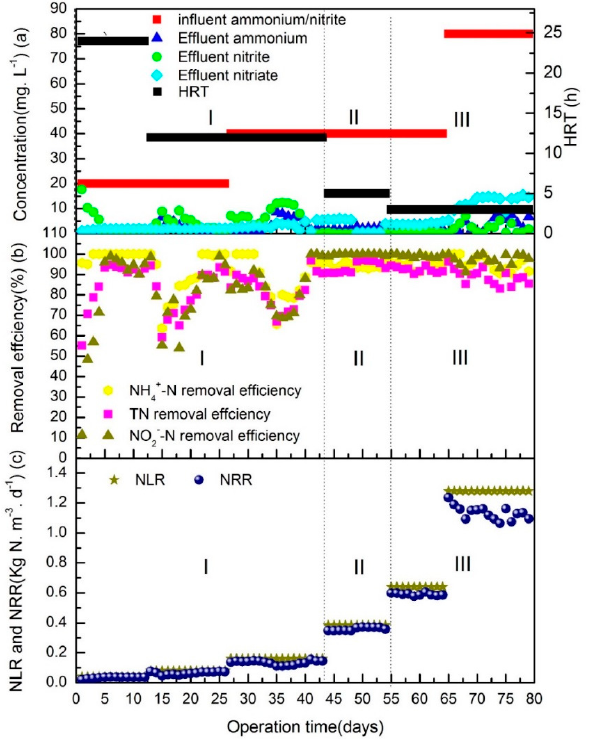
Figure 2. Performance of the Anammox-UASB reactor over 79 days of operation showing ( a ) concentrations of influent NH 4+ -N/NO 2 − -N, effluent NH 4+ -N, effluent NO 2 − -N, effluent NO 3 − -N, and hydraulic retention time (HRT); ( b ) NH 4 − -N removal efficiency, total nitrogen (TN) removal efficiency, and NO 2 − -N removal efficiency; and ( c ) nitrogen loading rate (NLR) and nitrogen removal rate (NRR). In order to further promote Anammox activity, the HRT was reduced from 24 h to 12 h on day 13 and the nitrogen loading rate (NLR) was increased to 0.08 kg N m − 3 d − 1 . On day 15, effluent